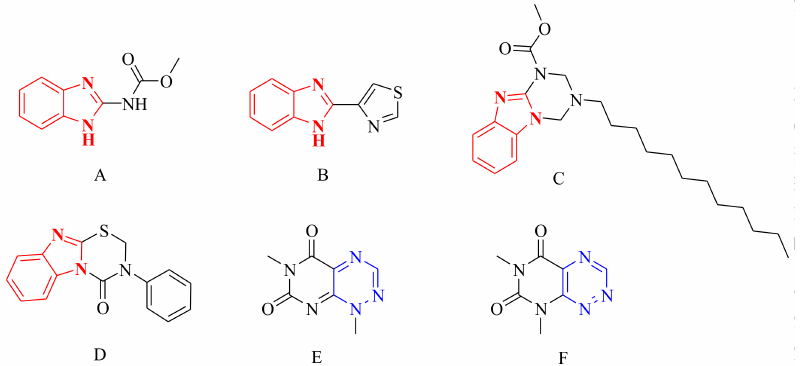
Figure 1. Compounds bearing a benzimidazole or triazine fragment. ( A ) Carbendazim; ( B ) Thiabendazole; ( C ) Hoe-22845; ( D ) 3-Phenyl-benzo[4,5]imidazo[2,1- b ][1,3,5]thiadiazin-4-one; ( E ) Toxoflavin; ( F )